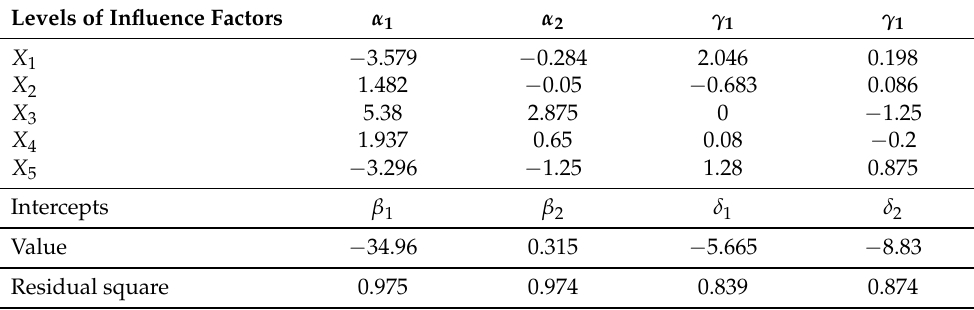
Table 5. Coefficients determined by multiple linear regression.